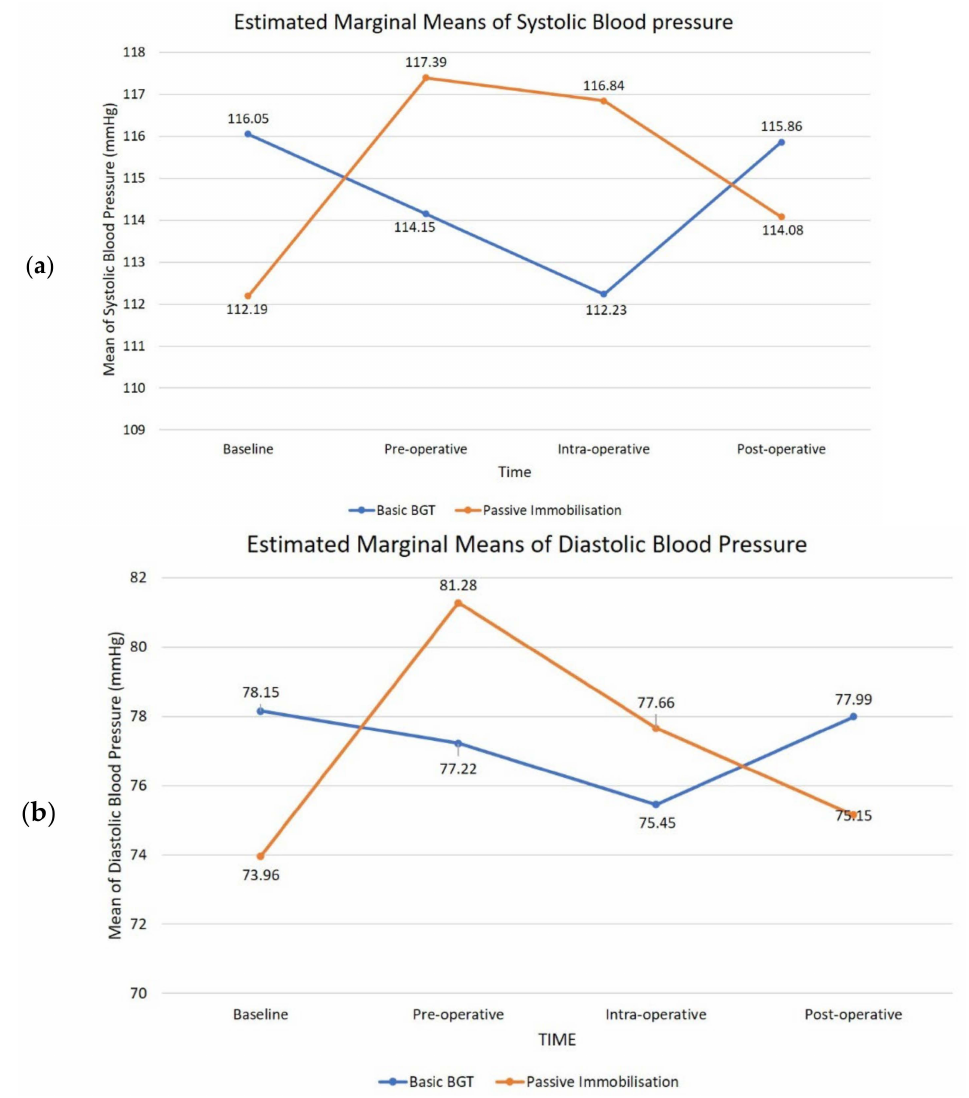
Figure 3. Graph pattern of cumulative means values of ( a ) systolic blood pressure; ( b ) diastolic blood pressure at four time